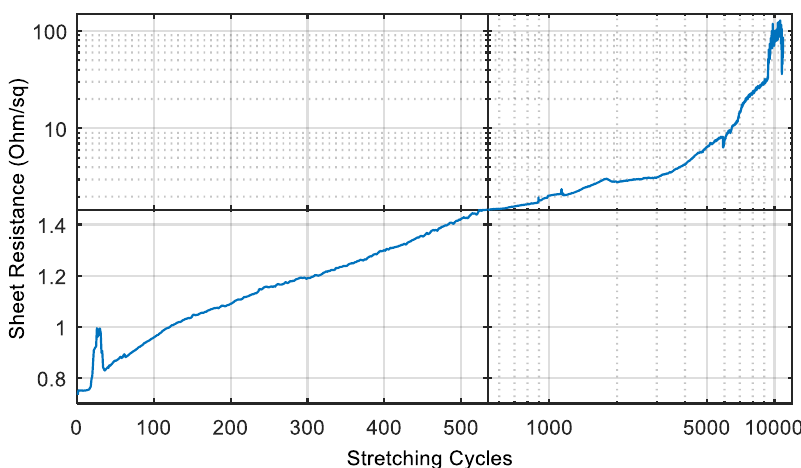
Figure 5. The sheet resistance of the inkjet-printed silver wires after stretching cycles that consist of a stretching of 20% that breaks the conductive paths in the wire and a relaxation after a hold-time of 10 s.